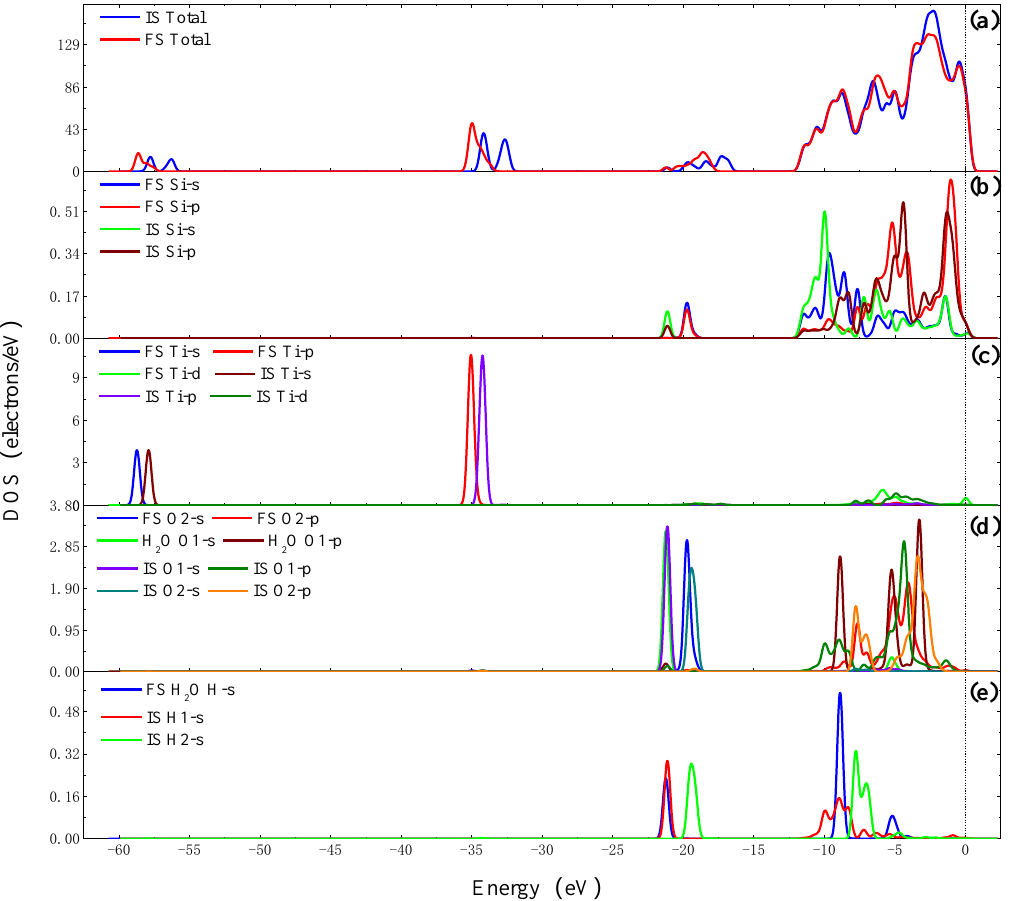
Figure 9. The DOS of TiO 2 cluster adsorbing on the Si surface. ( a ) Total DOS of FS and IS; ( b ) PDOS of target Si atoms of FS and IS; ( c ) PDOS of target Ti atoms of FS and IS; ( d ) PDOS of O1 and O2 atoms of FS and H 2 O molecule and IS; ( e ) PDOS of H1 and H2 atoms of FS and H 2 O molecule and IS.